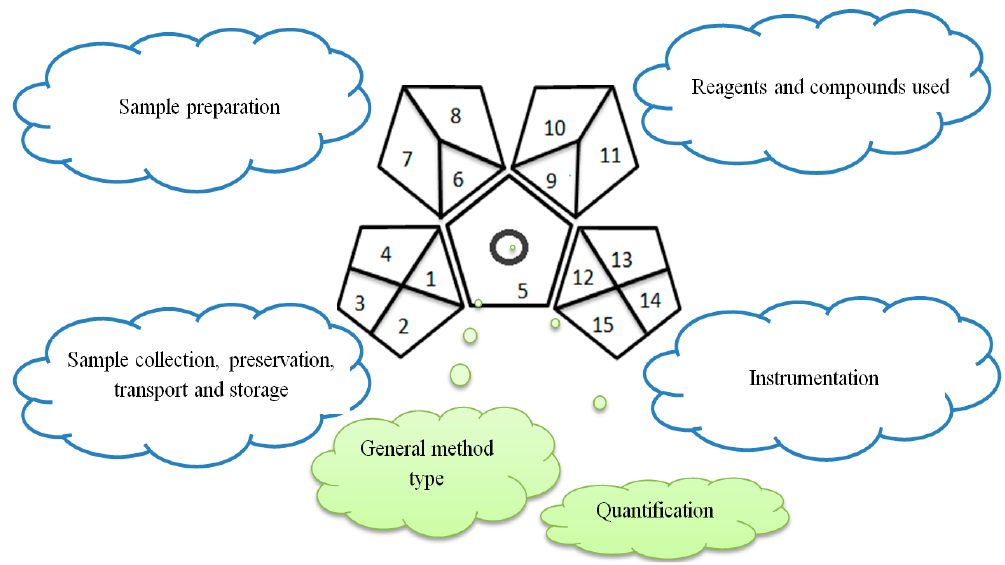
Figure 2. Green analytical procedure index pictogram with description.